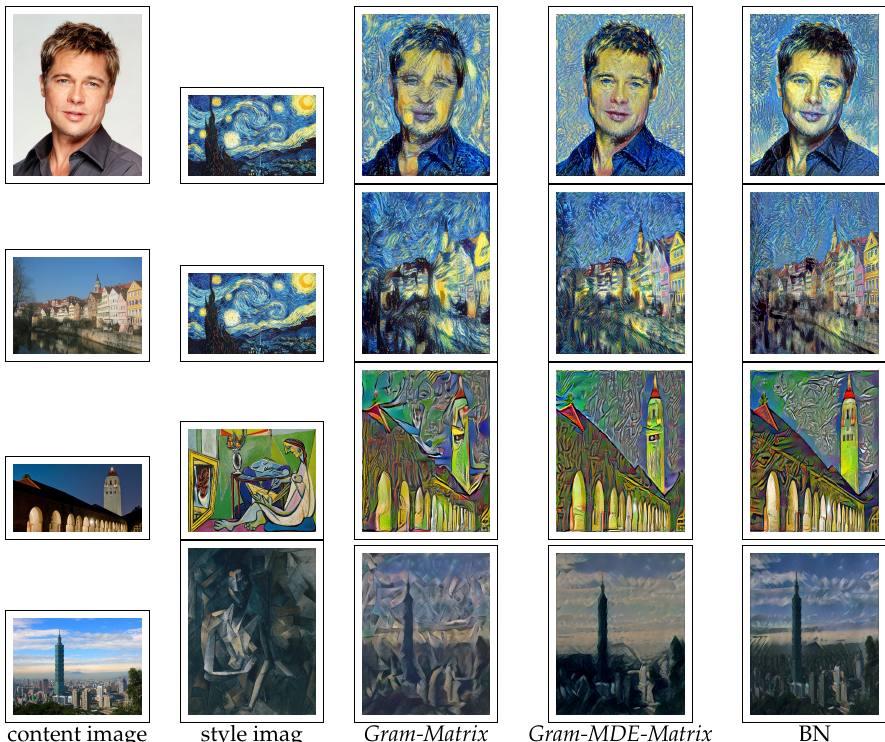
Figure 1. Results of Gram-Matrix , Gram-MDE-Matrix and Batch Normalization (BN) method. The ratio of α / β is 5 × 10 − 3 .